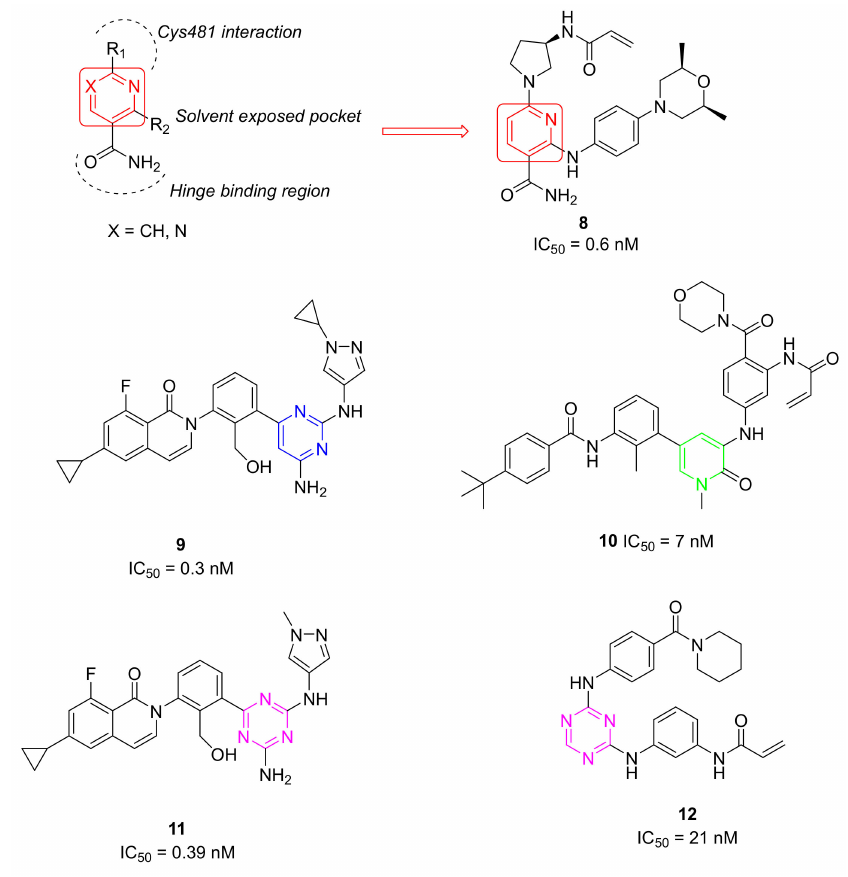
Figure 6. Pyrimidine, pyridine, pyridinone, and 1,3,5 triazine derivatives. Researchers at Carna Biosciences (Japan) obtained a series of novel pyrimidine ana- logues as potent, highly selective, non-covalent BTKIs by the isosteric substitution of the triazine nucleus with a pyrimidine one. These compounds showed a strict similarity with the previous compound RN-486, bearing the same substituted isoquinoline moiety. Derivative 9 (Figure 6) demonstrated a high affinity for BTKs (IC 50 = 0.3 nM) and an excellent kinase selectivity, probably due to the binding of the compound to the BTK inacti- vated conformation. It strongly inhibited BTK autophosphorylation in cells and showed a good oral bioavailability in mice. Unfortunately, compound 9 inhibits the hERG channel; consequently, further optimization to eliminate the hERG issue is necessary